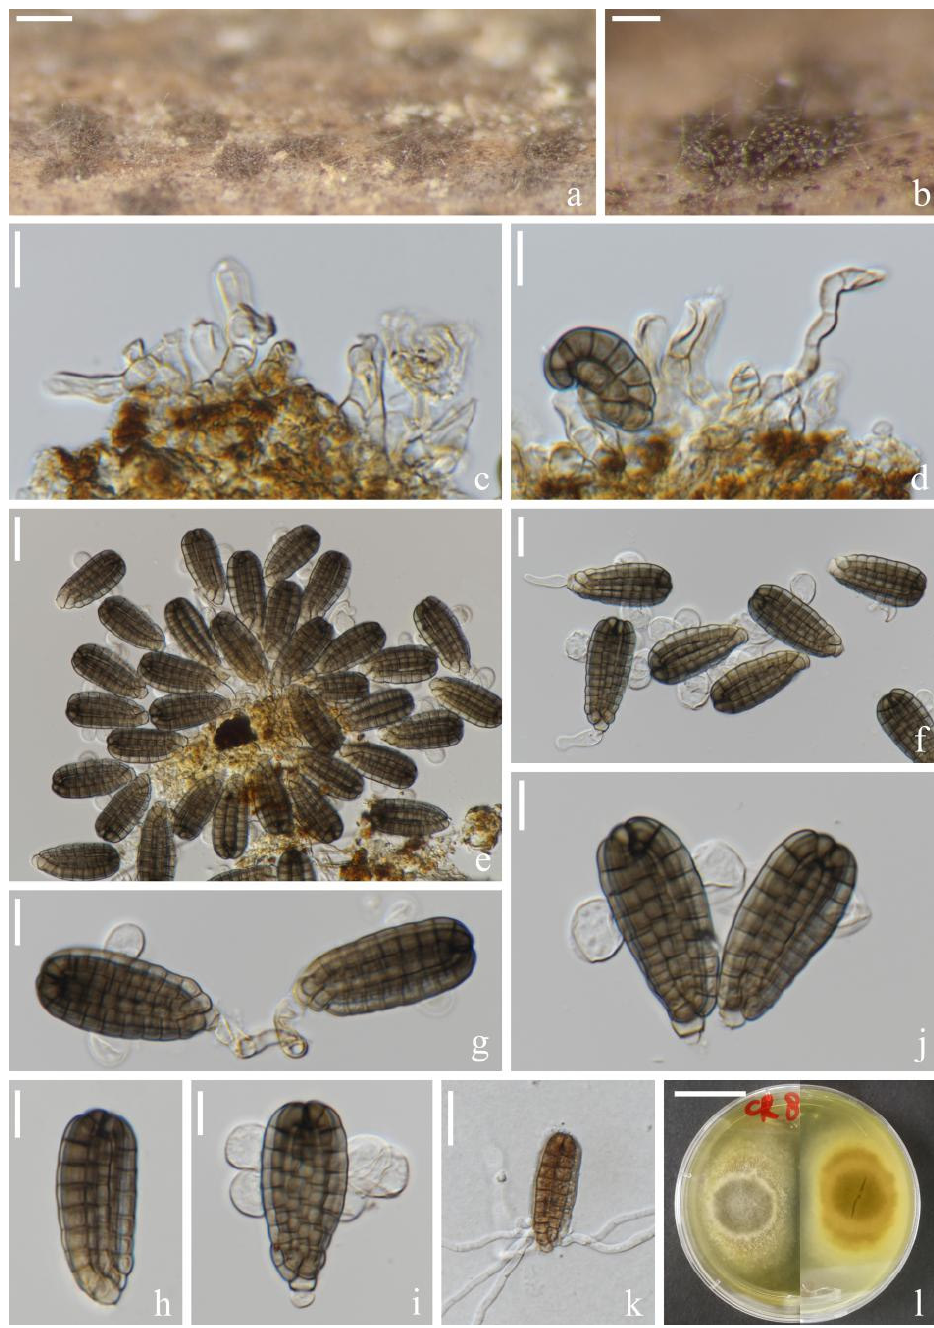
Figure 6. Dictyocheirospora nabanheensis (MFLU 22-0200). ( a , b ) Colonies on the substratum. ( c , d ) Conidiophores. ( e ) Conidia heap. ( f , g ) Conidiogenous cells, conidia and appendages. ( h ) Conidia. ( i , j ) Conidia with appendages. ( k ) Germinating conidium. ( l ) Culture colonies on PDA, reverse (left) and obverse (right). Scale bars: ( a ) 100 μ m, ( b ) 200 μ m, ( c , d , g – j ) 10 μ m, ( e , f , k ) 20 μ m and ( l ) 2 cm.